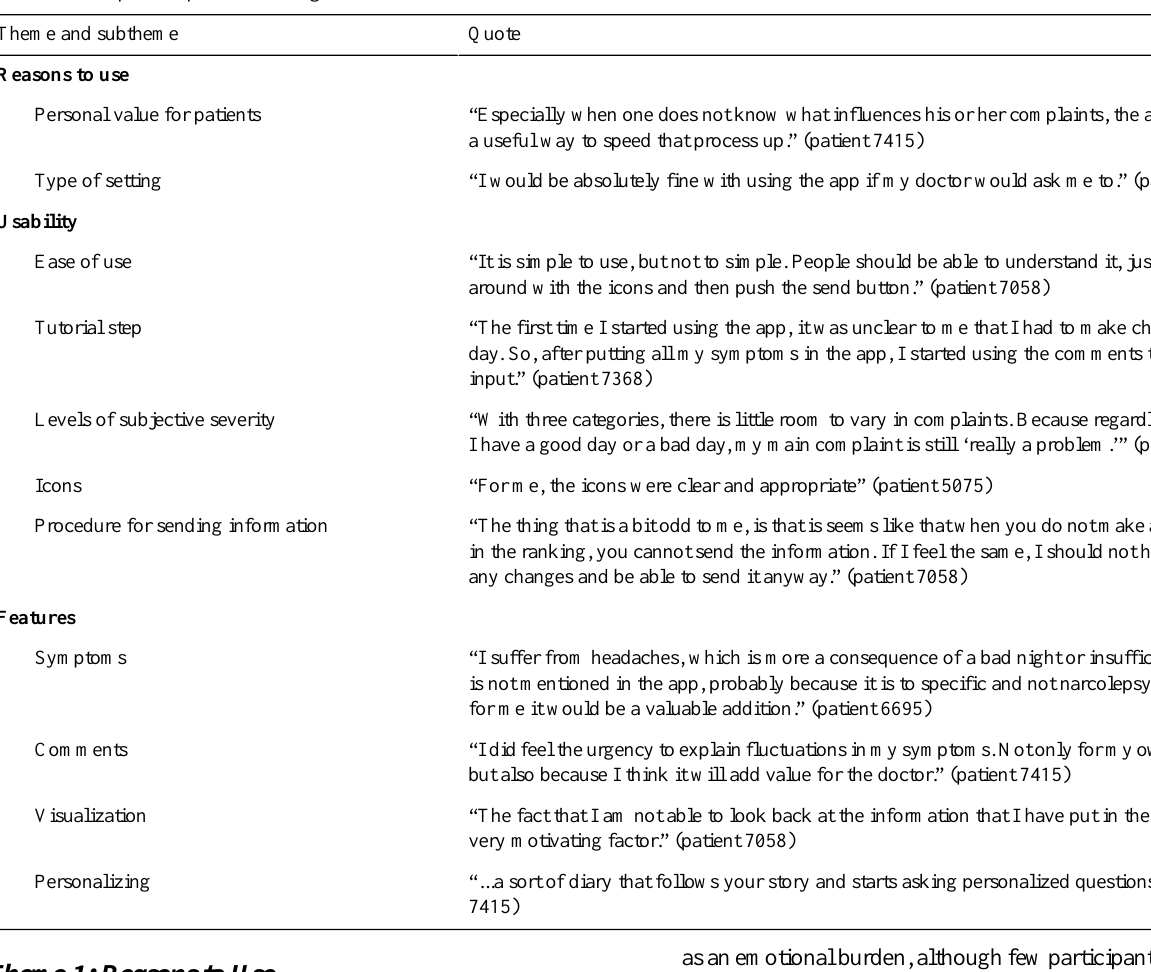
Table 3. Examples of quotes matching the themes. QuoteTheme and